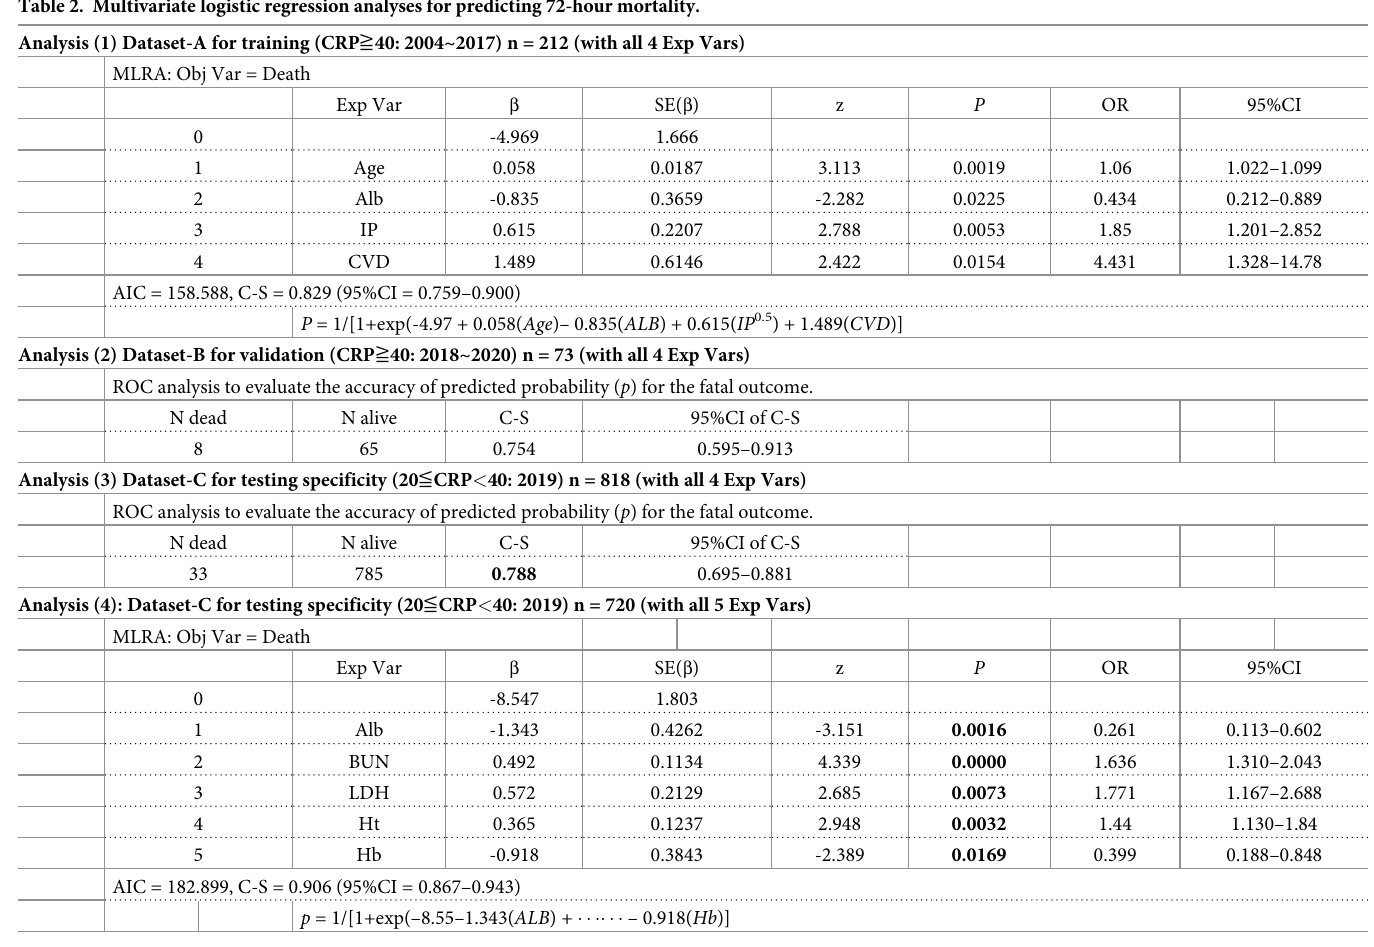
Obj Var = object variable; Exp Var = explanatory variable; β = partial regression coefficient; SE = standard error; OR = odds ratio; C-S = C-statistics; ALB = albumin; BUN = blood urea nitrogen; IP = inorganic phosphate; CVD = cardiovascular diseases; ALB = albumin; BUN = blood urea nitrogen; IP = inorganic phosphate; Ht = haematocrit; Hb =